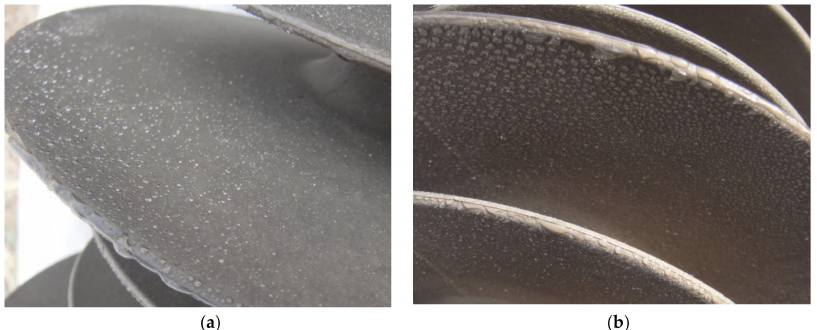
Figure 13. The hydrophobicity of the composite insulators. ( a ) The upper surface; ( b ) the lower surface.